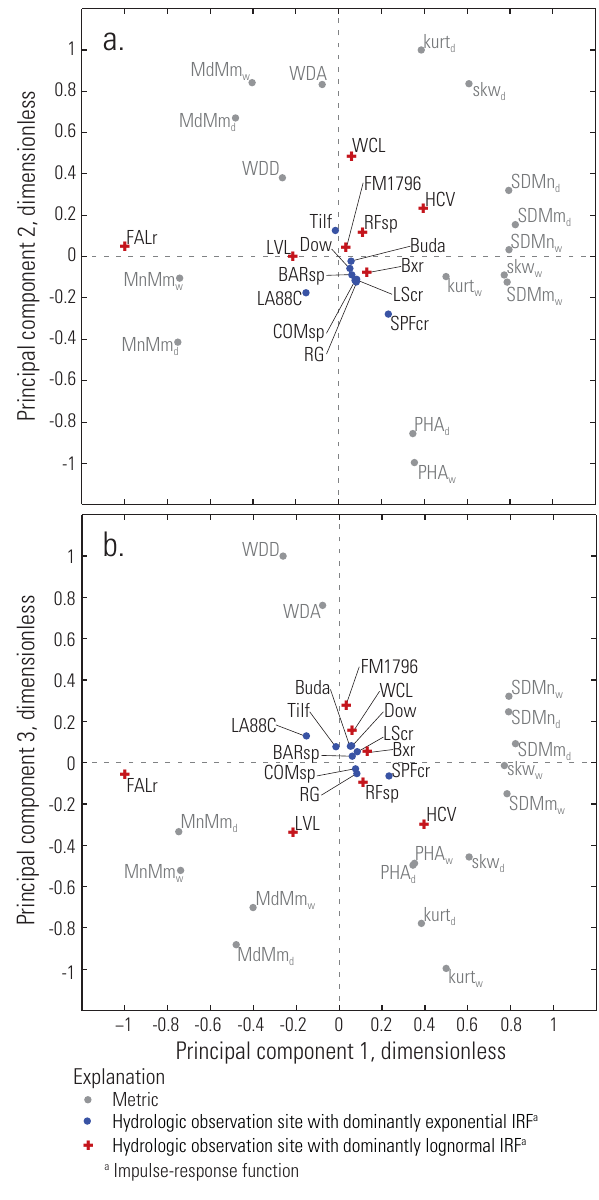
Fig. 4. Principal component biplots showing simulated sites and metrics for the Edwards and Madison aquifers for (a) the first two principal components and (b) the first and third principal compo- nents. Plotting positions were scaled to range from − 1 to 1 to show sites and metrics on a similar scale. Site and metric labels are shown in Tables 2 and 3. See Table S6 in the Supplement for plotting